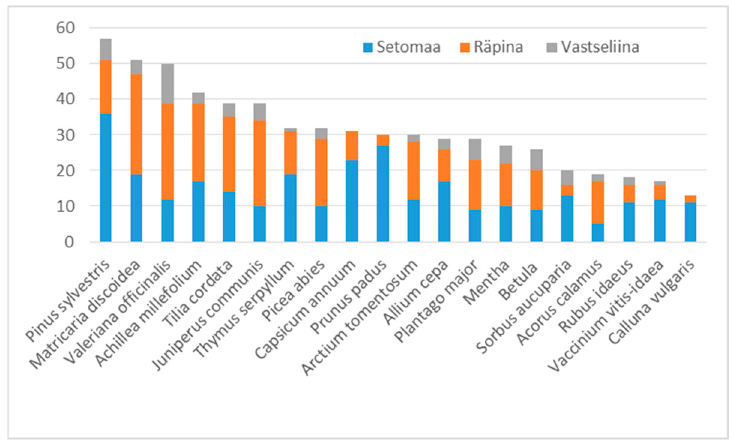
Figure 4. The 20 most used taxa and their UR distribution in the parishes.